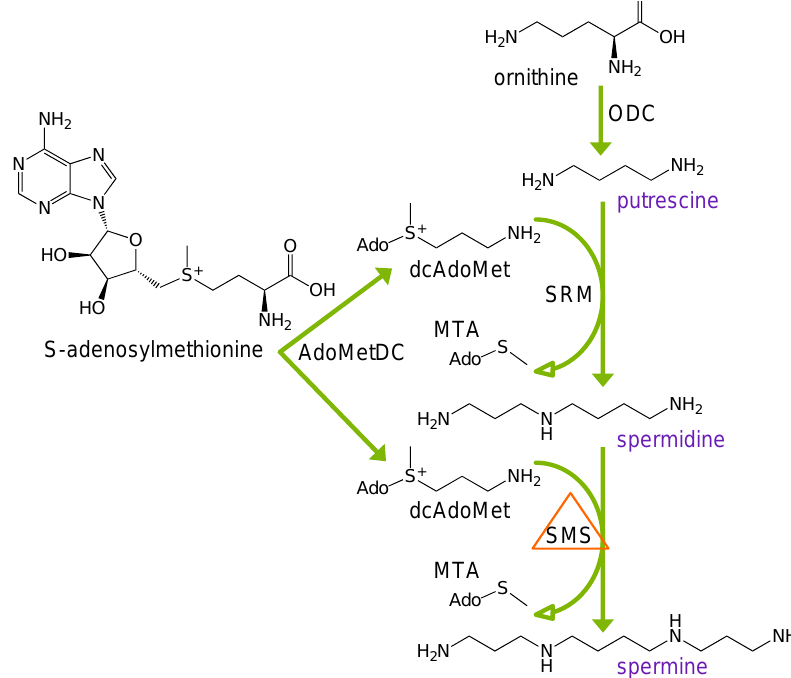
Figure 1. Mammalian polyamine biosynthesis. Polyamines are indicated in purple. Putrescine is created from ornithine via ornithine decarboxylase (ODC). Conversion of putrescine to spermidine and spermidine to spermine occurs through spermidine synthase (SRM) or spermine synthase (SMS), respectively. Both enzymes require the activity of S-adenosylmethionine decarboxylase (AdoMetDC) for the provision of the aminopropyl group donor (decarboxylated AdoMet, dcAdoMet). Snyder-Robinson Syndrome (SRS) patients are deficient in SMS activity, resulting in decreased spermine and accumulation of spermidine. MTA = methylthioadenosine.